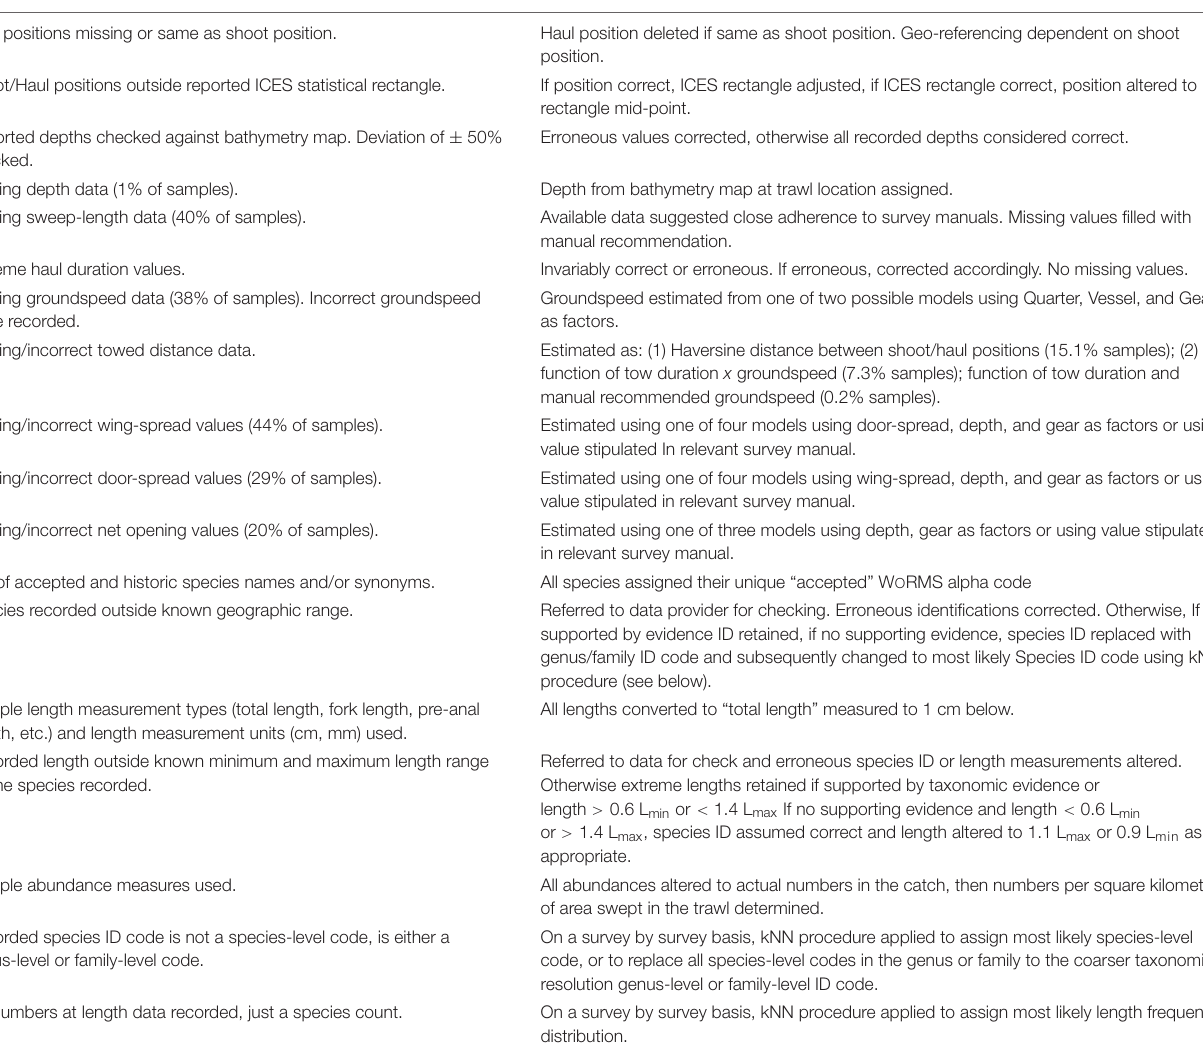
TABLE 2 | Summary of issues identified in the groundfish survey data stored on the DATRAS portal or on national databases and approaches adopted to address these. Issue Solution Haul positions missing or same as shoot position. Haul position deleted if same as shoot position. Geo-referencing dependent on shoot position. Shoot/Haul positions outside reported ICES statistical